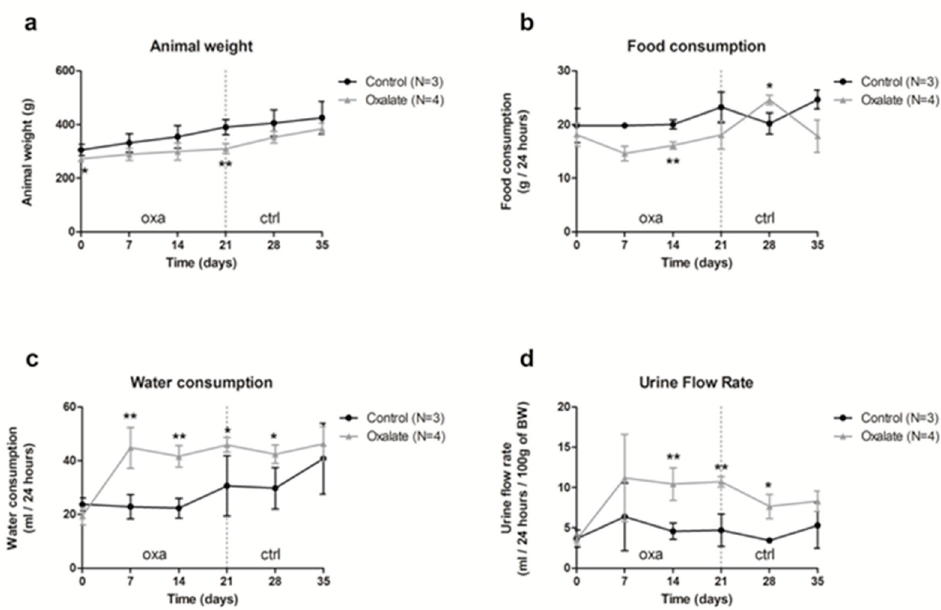
Figure 1. Impact of the 5-week regimen (3 weeks of OXA diet + 2 weeks of control diet) on metabolic parameters: ( a ) animal weight (grams); ( b ) food consumption (grams/24-h); ( c ) water consumption (mL/24-h); ( d ) urine flow rate (mL/24-h/100 g of body weight). Results are expressed as mean ± SD. * p ≤ 0.05; ** p ≤ 0.01, versus control. Control n = 3, oxalate n =